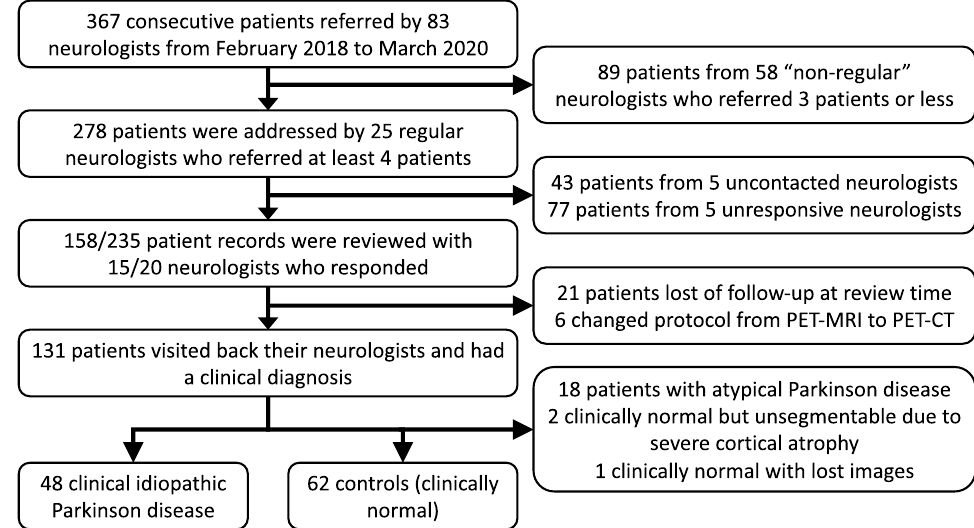
Fig. 1 Flowchart of the patient selection process. From 367 patients, 110 were finally retained, including 48 IPD and 62